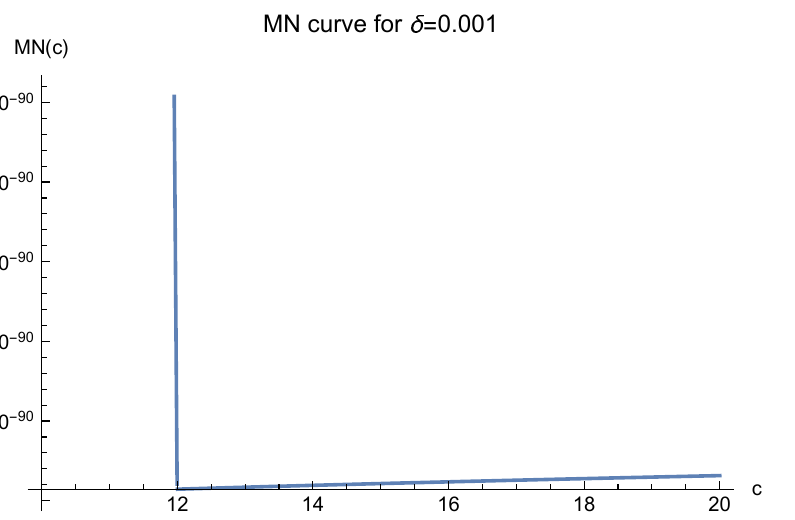
Figure 6. MN curve for δ = 0.001 where d = 1, β = 1, b 0 = 1 and σ = 10 − 5 . Note that in these figures, c = 12 always corresponds to the minimal value of MN ( c ) .